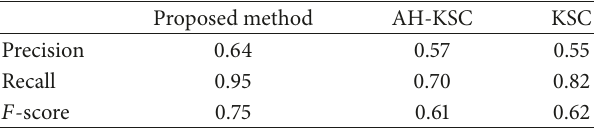
Table 1: Overall accuracy of community detection for the proposed method, AH-KSC, and